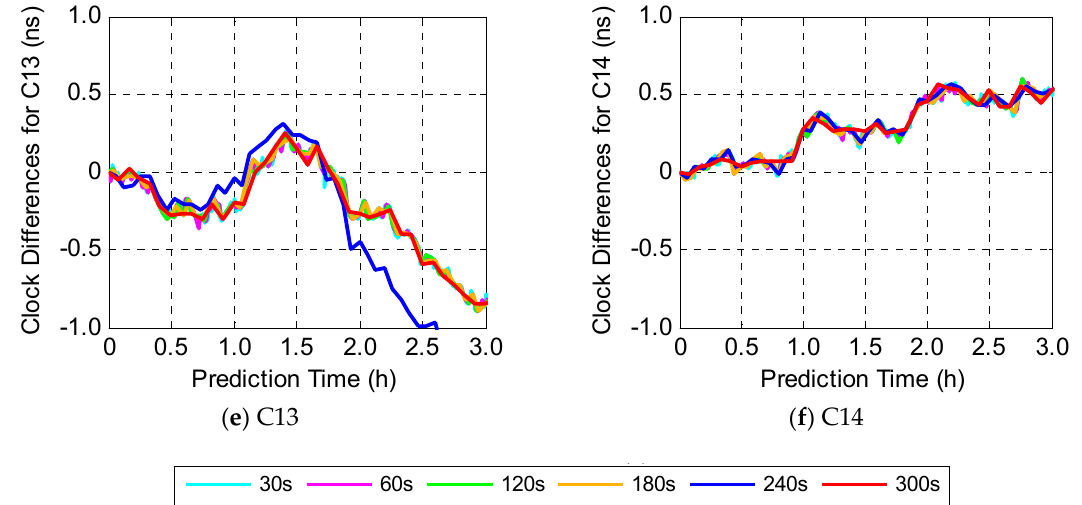
Figure 6. Clock differences between true (GFZ precise clock products) and prediction, using different sampling interval of input data.